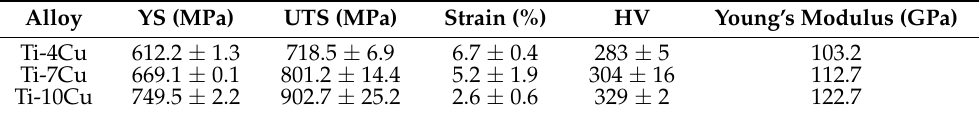
Figure 8. Tensile stress-strain curves of the as-cast Ti-xCu alloys. Table 4. Mechanical properties of the as-cast Ti-xCu alloys.